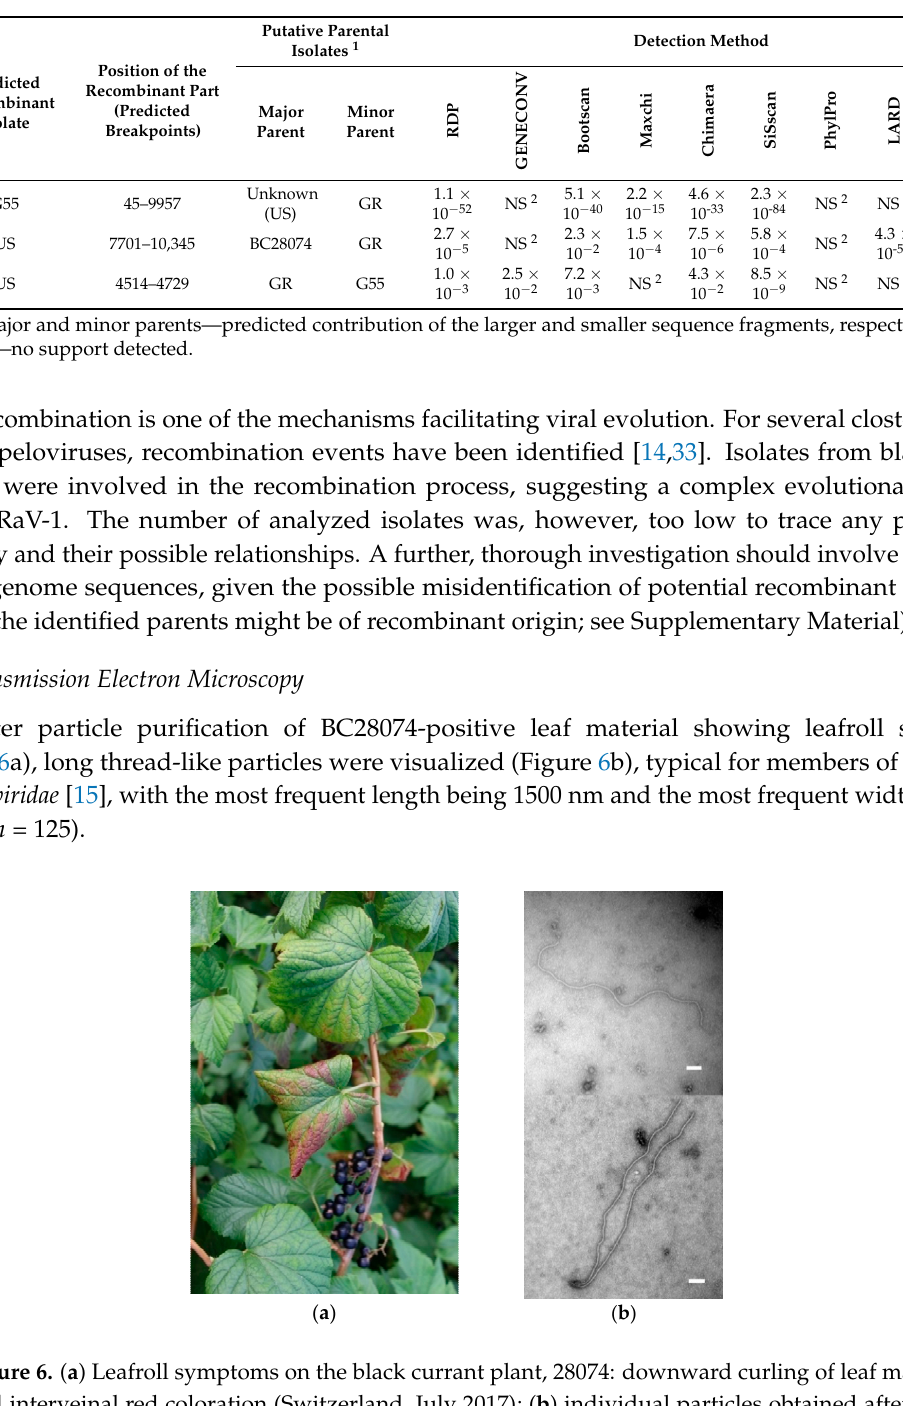
Table 3. Recombination analysis of BcLRaV-1 isolates.